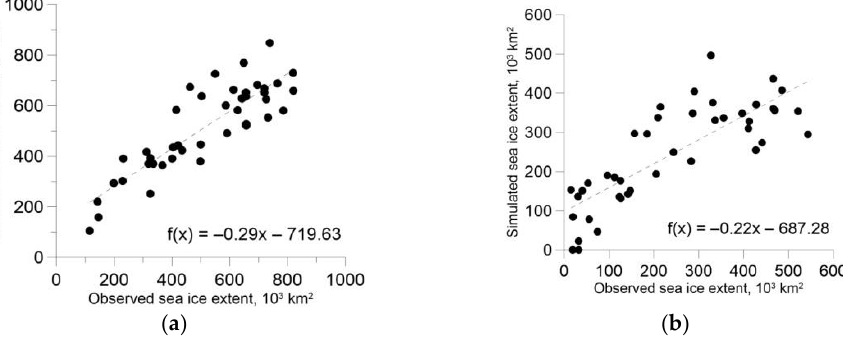
Figure 5. Comparing of calculated and observed sea ice extent in the Kara Sea in July ( a ) and in August ( b ) for 1979 – 2021.